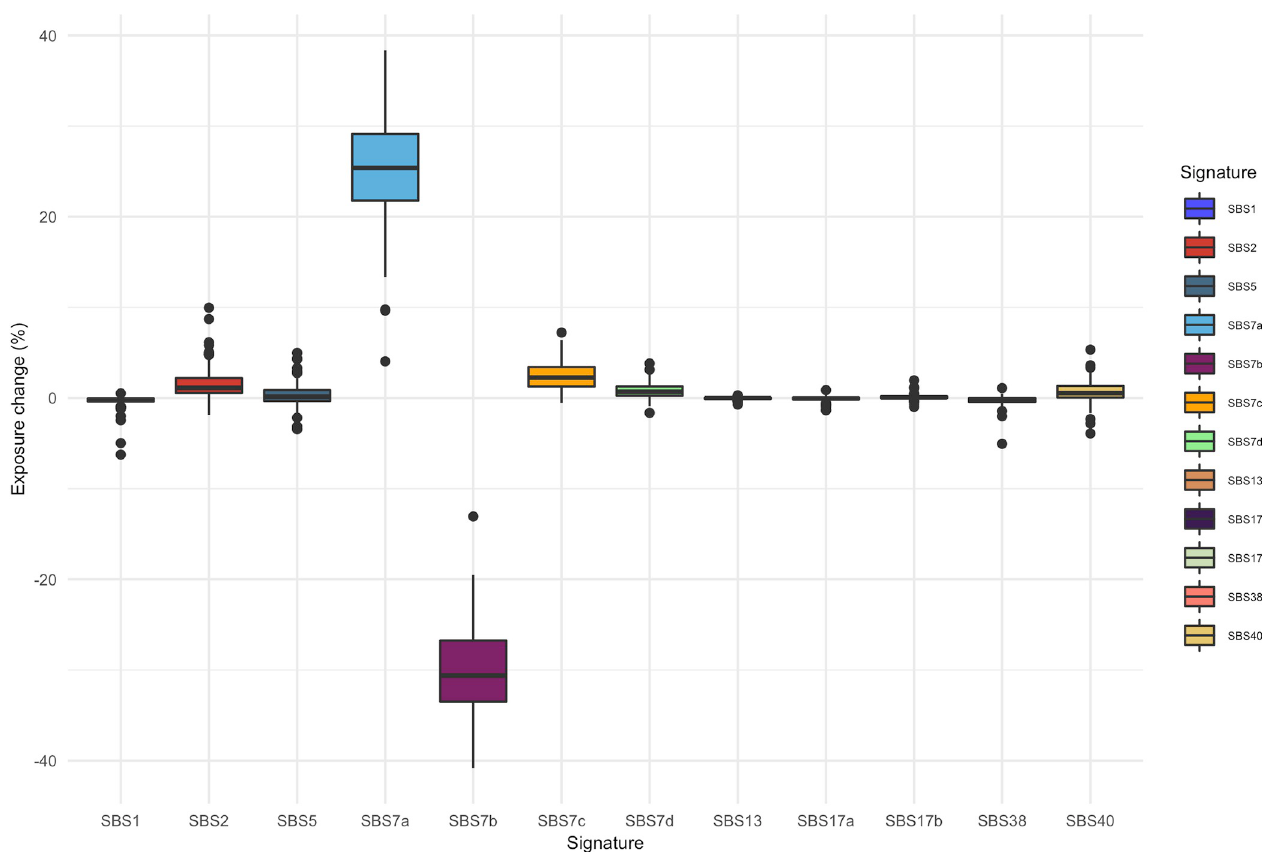
Fig 3. Similar signature changes at the 1:47,000,000–1:51,000,000 region in 55/107 melanoma samples. Each boxplot shows the distribution of activity changes for a particular signature at the recurrent changepoint region 1:47,000,000–1:51,000,000.